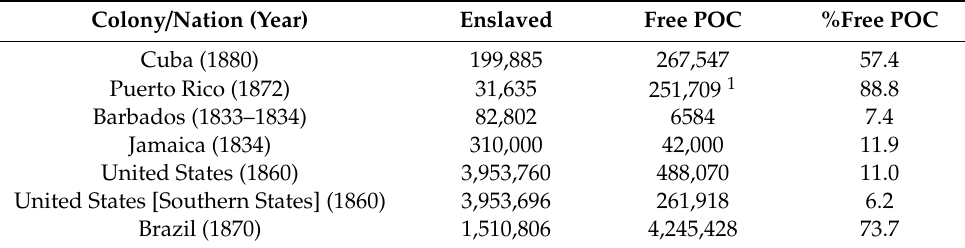
Table 1. Comparison of Enslaved and Free